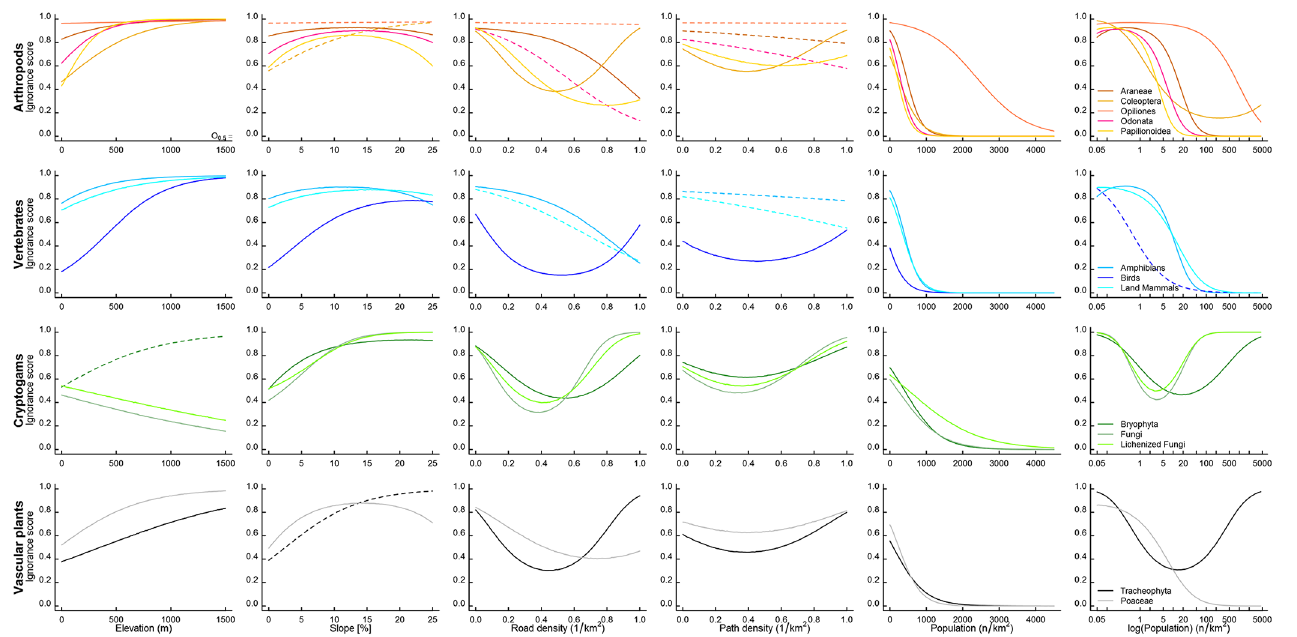
Fig 4. The relationship between ignorance score and environmental variables. The relationship between ignorance score and six environmental variables: elevation, slope, road density, path density, population density and log population density, for each taxonomic group studied when O 0.5 = 1. Solid line indicates quadratic relationship, while dashed line indicates that only a linear relationship improved the model fit compared to the null model (only best models are drawn).